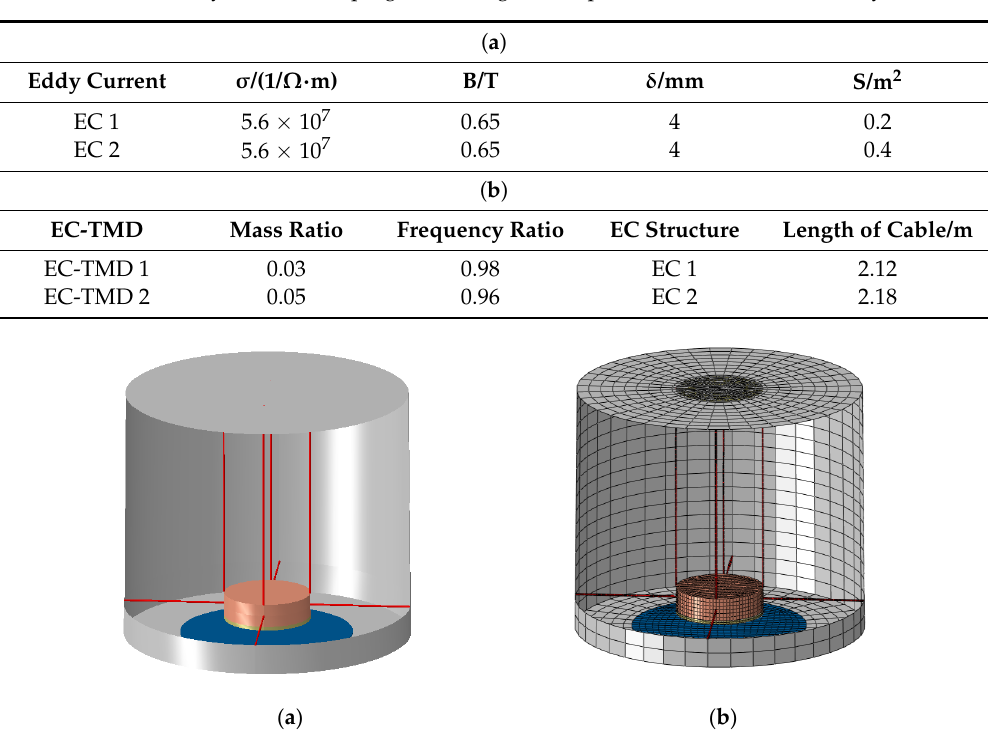
Table 6. Configuration parameters of EC-TMD system used in the OWT structure: ( a ) Configuration parameters of the eddy current damping; ( b ) Configuration parameters of the EC-TMD system.